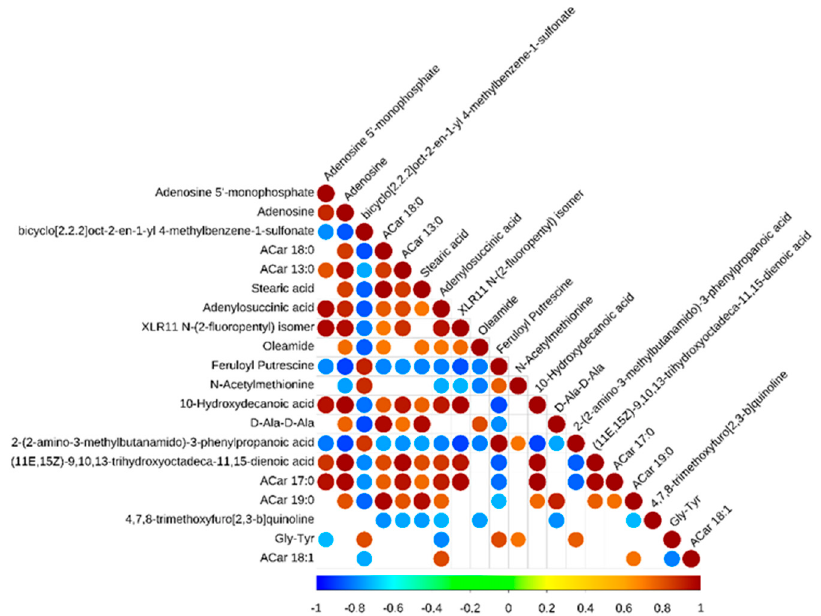
Figure 4. Correlation heat map of differences in metabolic biomarkers between Black Tibetan and Chaka sheep.